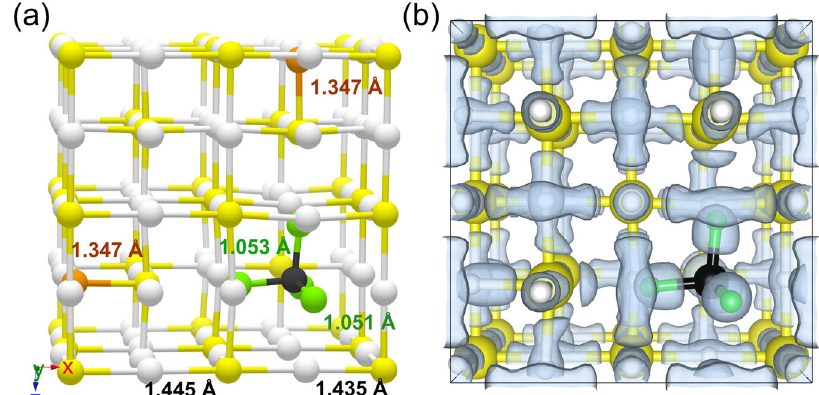
Fig. 2 Geometry and electronic structure of T d -CS 15 H 48 . a Optimized geometry and b electron localization function (ELF; isovalue = 0.8) of the CH 4 -based C 0.0625 S 0.9375 H 3 ( T d -CS 15 H 48 , space group Amm 2) in which the carbon atom is quasi-tetrahedrally coordinated by hydrogen atoms at 270 GPa. Sulfur/carbon/hydrogen atoms are yellow/black/white and select geometric parameters are provided. Hydrogens bonded to carbon/sulfur only are green/orange. ELF contour plot is provided in Supplementary Fig.